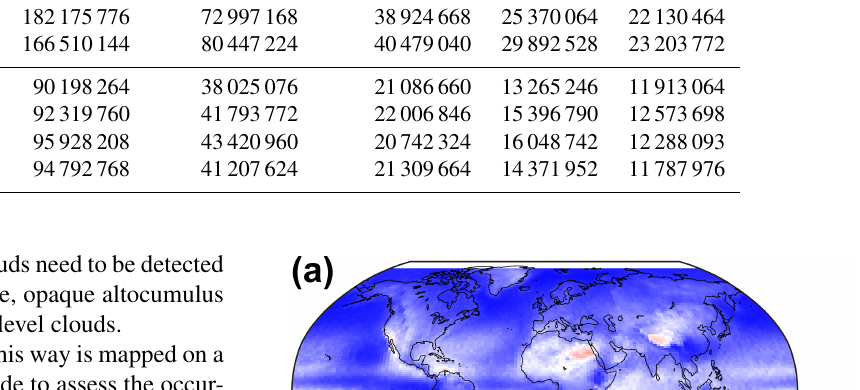
Table 1. Number of considered CALIOP cloud profiles per category. Ac refers to transparent altocumulus. Ci only and Ac only refer to those profiles in which the view of the respective cloud type from the ground would not be distorted by the absence of opaque clouds underneath. Category All Cloudy Cloudy with Ci Cloudy with Ac Ci only Ac only All 569254944 348685952 164447440 79403704 59082728 45334236 Day 282916480 182175776 72997168 38924668 25370064 22130464 Night 166510144